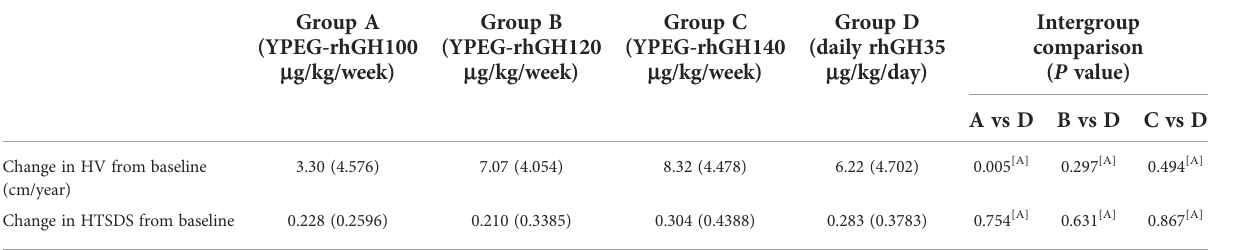
TABLE 4 Statistical analysis of improvement of HV and HTSDS after 12 weeks of